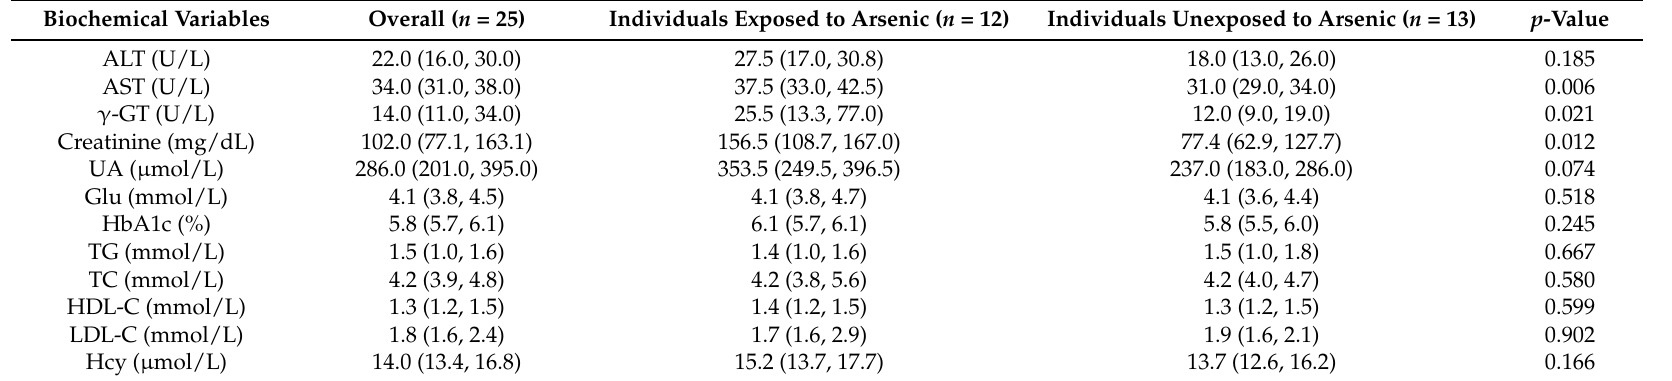
Table 2. Levels of biochemical indexes for family members exposed and not exposed to arsenic a .